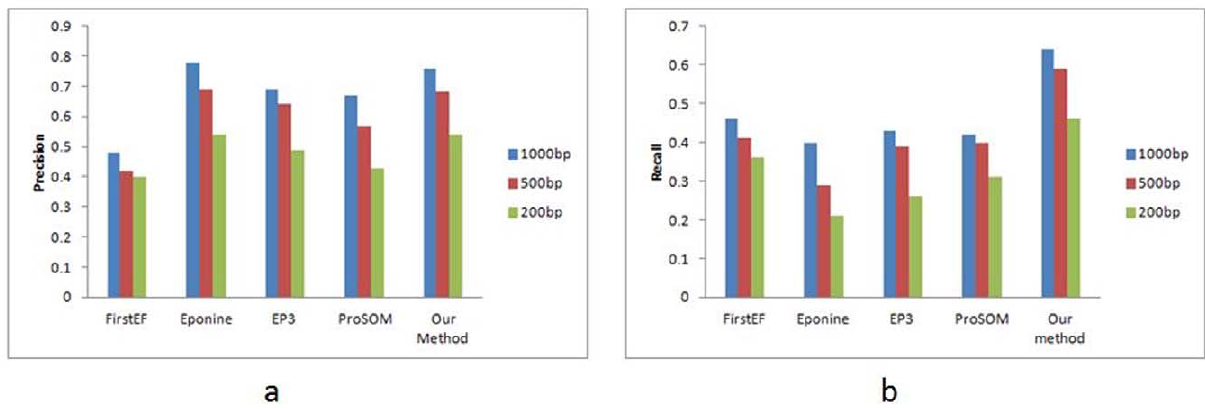
Figure 6. Genome wide precision and recall comparison with other methods. a ) Comparison of genome wide precision value at different maximum allowed distances from annotated TSS (1000 bp, 500 bp and 200 bp). b ) Comparison of genome wide Recall value at different maximum allowed distances from annotated TSS (1000 bp, 500 bp and 200 bp).